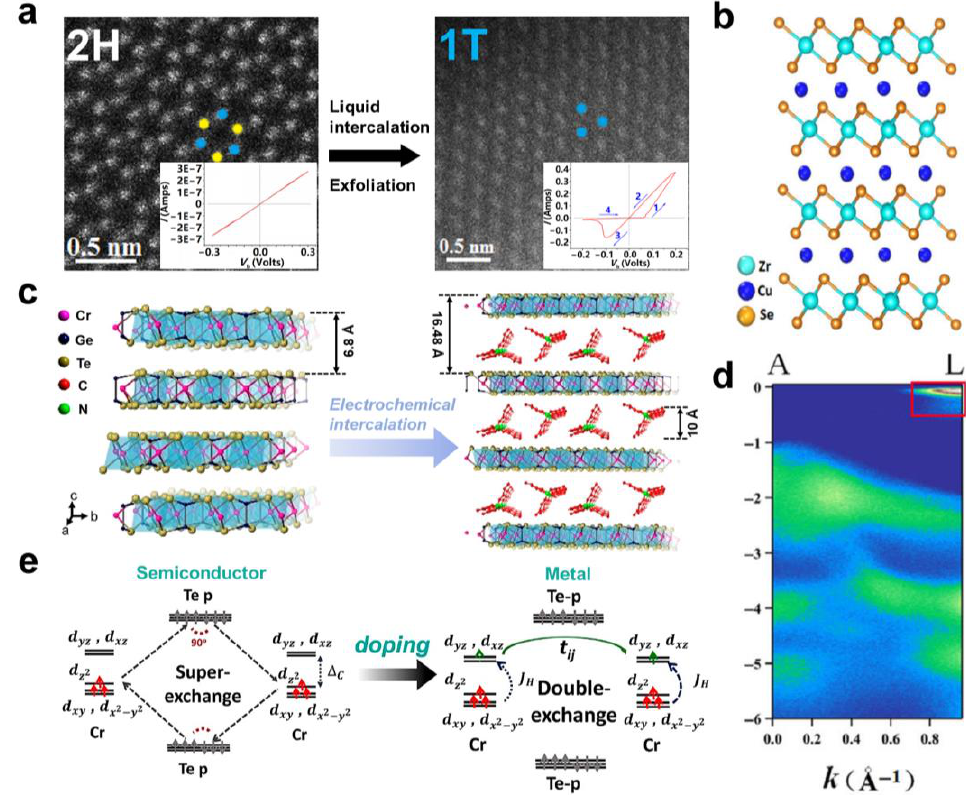
Figure 6. ( a ) The high-angle annular dark-field scanning transmission electron microscopy image of MoS 2 flake. The blue and yellow dots represent Mo and S atoms, respectively. The inset shows the characteristic curve of I − V at room temperature. Reproduced with permission from Ref. [66]. Copy- right 2016, American Chemical Society. ( b ) Schematic diagram of the lattice structure of Cu 0.07 ZrSe 2 . Reproduced with permission from Ref. [67]. Copyright 2018, Springer Nature. ( c ) Schematic diagram of the lattice structure of Cr 2 Ge 2 Te 6 before and after intercalation. Reproduced with permission from Ref. [68]. Copyright 2019, American Chemical Society. ( d ) The energy band structure of Cu 0.07 ZrSe 2 shown by ARPES. Reproduced with permission from Ref. [67] Copyright 2018, Springer Nature. ( e ) Schematic diagram of the superexchange interaction in the semiconducting Cr 2 Ge 2 Te 6 and the double exchange interaction in the metallic (TBA)Cr 2 Ge 2 Te 6 . Reproduced with permission from Ref. [68]. Copyright 2019, American Chemical Society.